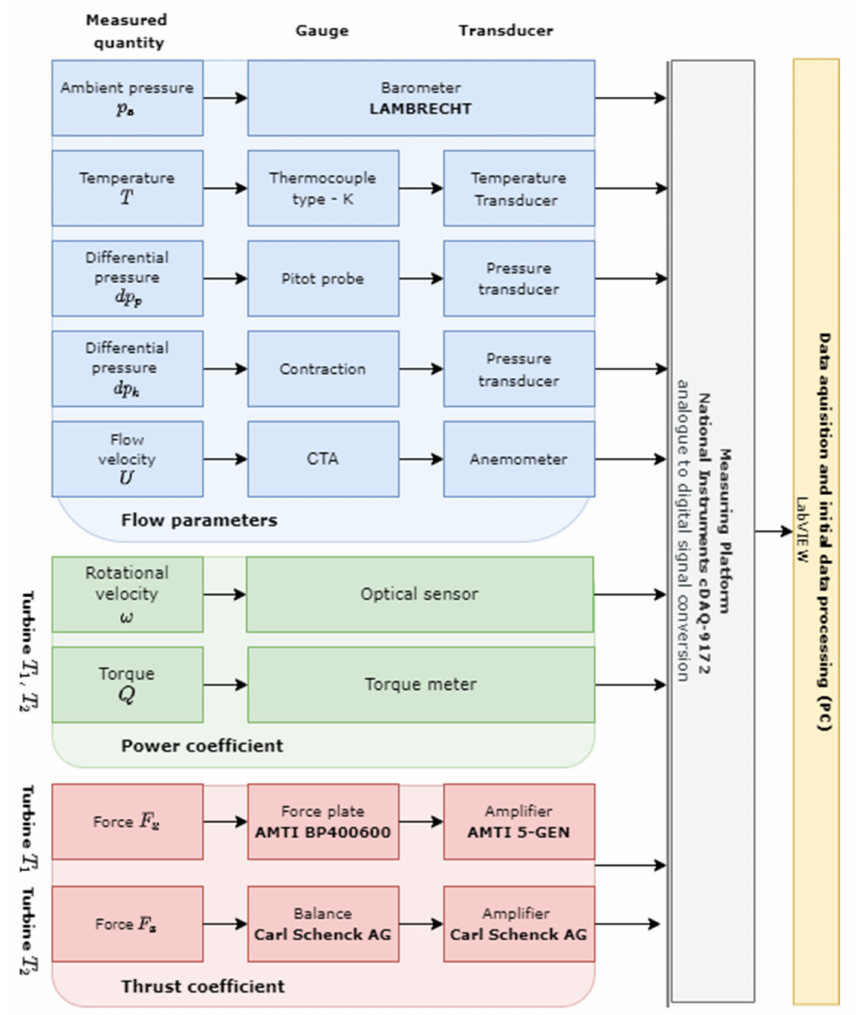
Figure 6. Scheme of the measurement